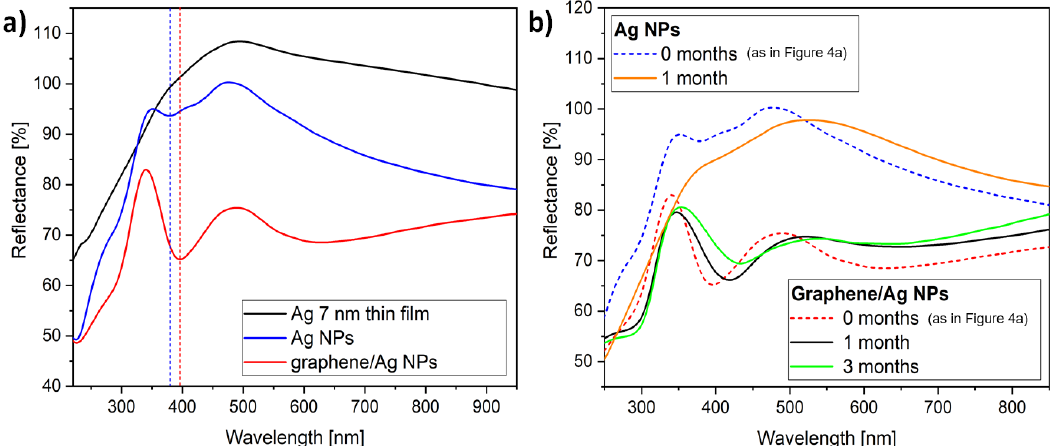
Figure 4. ( a ) Optical reflectance spectra of the as-deposited Ag thin film (black), the Ag NPs produced by annealing (blue), and the graphene-covered Ag NPs (red). The LSPR of Ag NPs (blue dashed line) is redshifted when covered with graphene (red dashed line). ( b ) Optical reflectance spectra measured after one month on bare Ag NPs (orange) and on graphene–Ag NPs (black). For better comparison, the initial spectra from ( a ) are also shown (blue dashed and red dashed lines, respectively). The spectrum of graphene–Ag NPs measured after 3 months is also plotted (green).